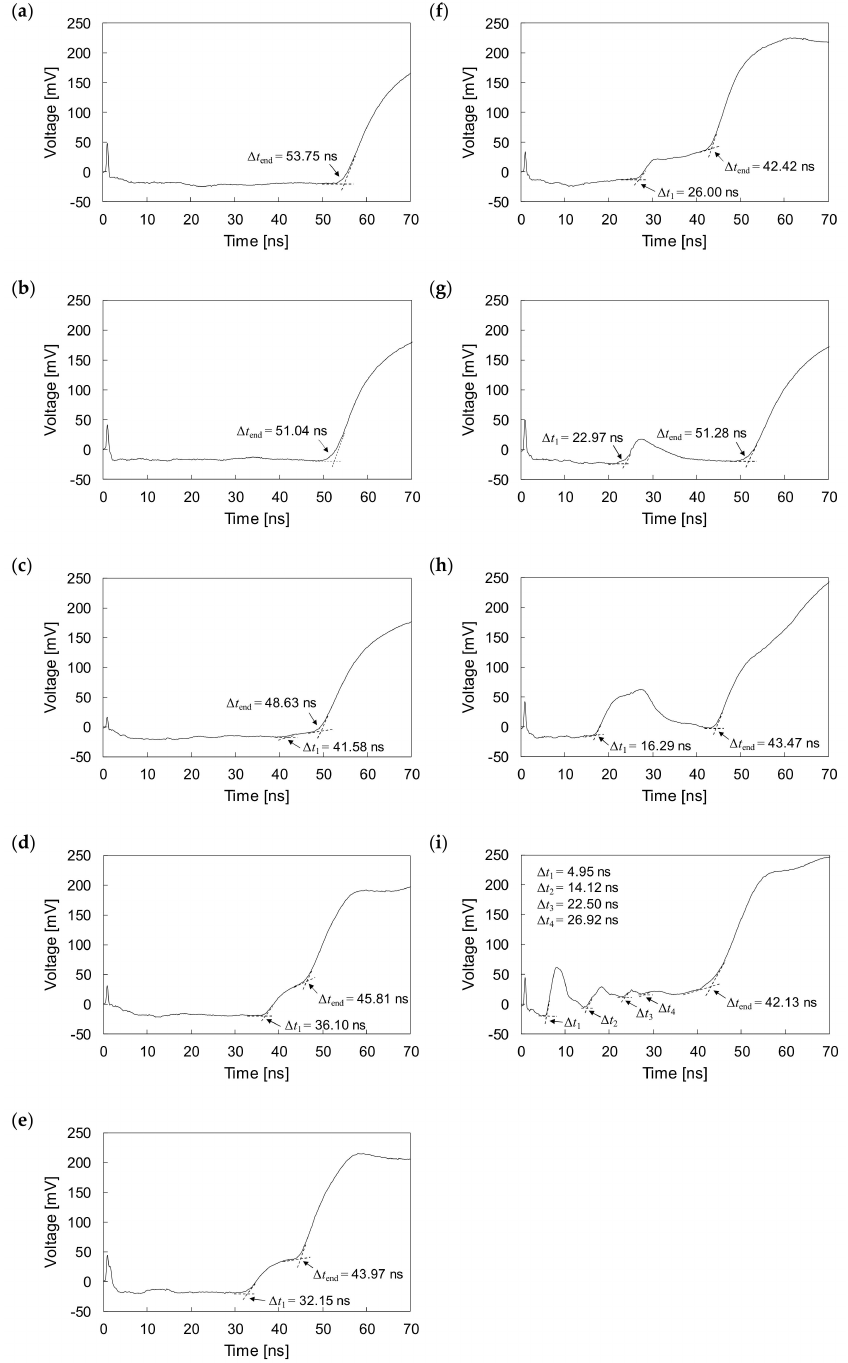
Figure 11. Measured signals in embedded condition for rock bolts: ( a ) F0 (NGR = 0%); ( b ) D1 (NGR = 10%); ( c ) D2 (NGR = 20%); ( d ) D3 (NGR = 30%); ( e ) D4 (NGR = 40%); (f) D5 (NGR = 50%); ( g ) V1 (NGR = 10%); ( h ) V4 (NGR = 40%); ( i ) V5 (NGR =